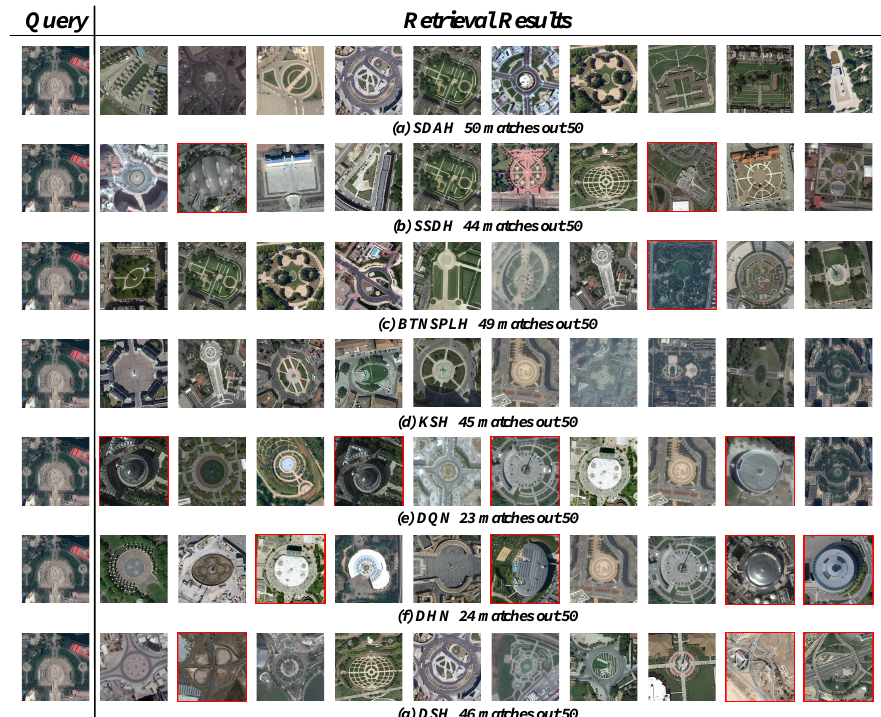
Figure 18. Retrieval examples of “Square” within AID dataset based on the 128 bits hash codes learned by the different hash learning methods. The first images in each row are the queries. The remaining images in each row are the Top 10 retrieval results. The incorrect results are tagged in red, and the number of correct results among Top 50 retrieval images is provided for reference.